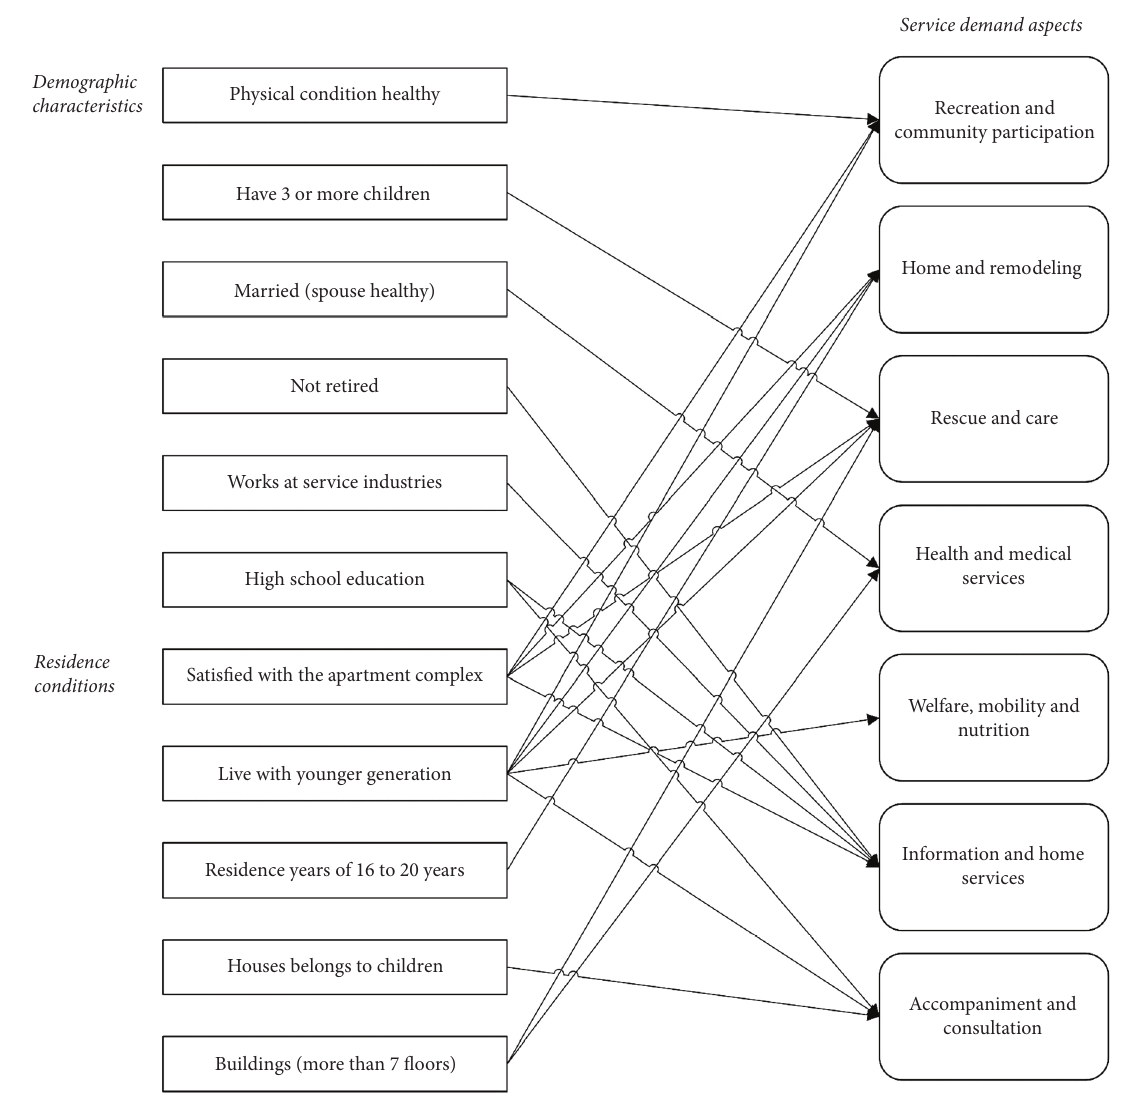
Figure 1. Associations between characteristics and higher service demand